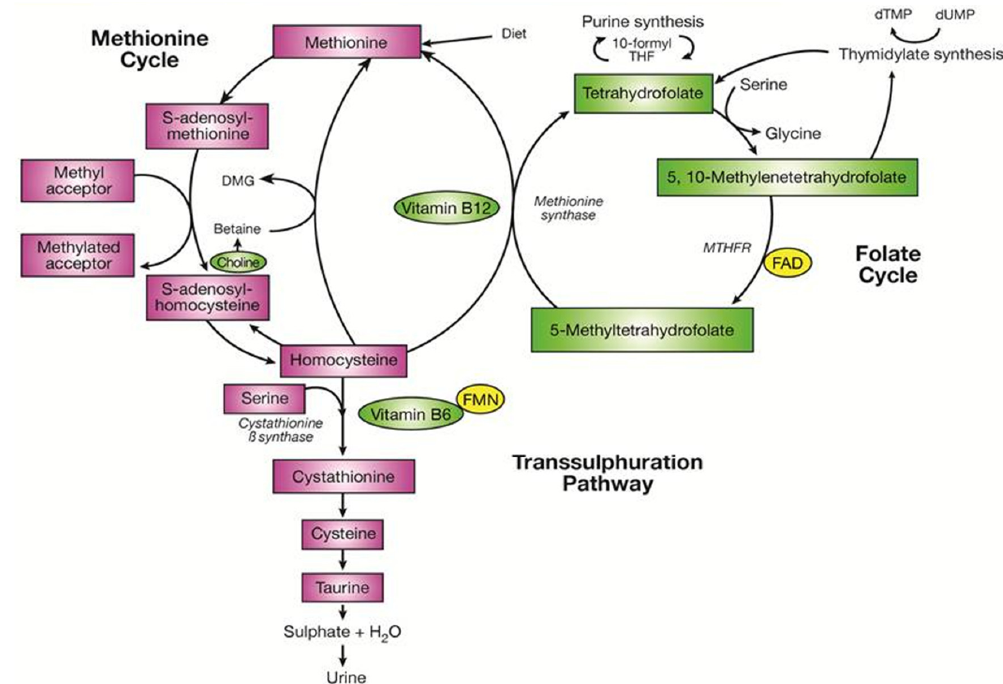
Figure 1. One-carbon metabolism pathway reproduced from Clarke et al. [31]. FAD, flavin adenine dinucleotide; FMN, flavin adenine dinucleotide.